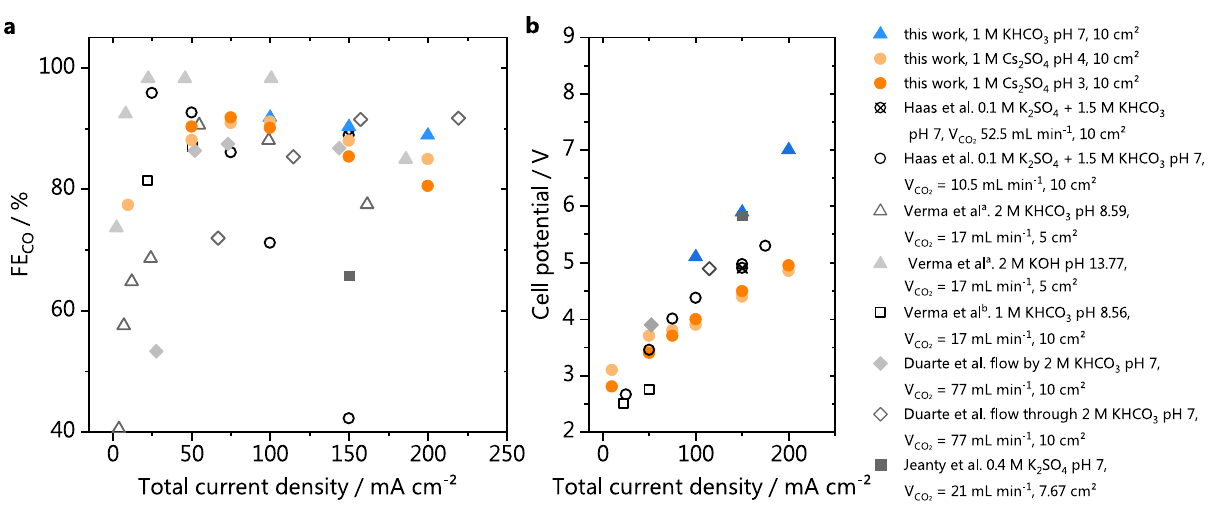
Fig. 5 Comparison of our results in acidic media with literature values. a Faradaic ef fi ciencies and ( b ) cell potentials reported in different work from literature, in which CO 2 electrolysis was performed in neutral to alkaline media, using GDEs equal or larger than 5 cm 2 . Results from this work shown in orange circles (acidic media) and blue triangles (neutral media). Data points extracted from the work of Haas et al. 15 , Verma et al. a 13 , Verma at al. b 14 , Duarte et al. 16 and Jeanty at al. 17 shown in